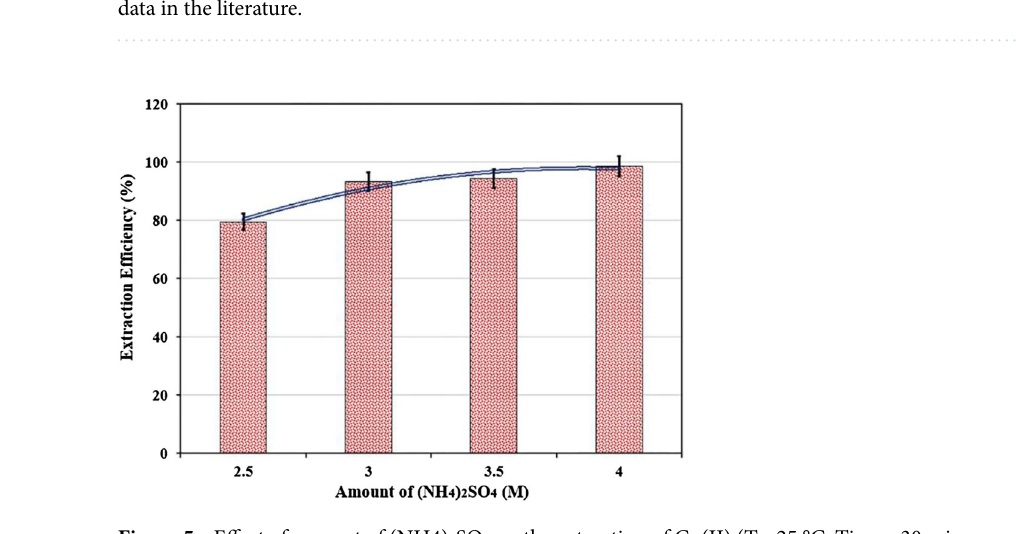
Figure 5. Effect of amount of (NH4) 2 SO 4 on the extraction of Co(II) (T = 25 °C, Time = 30 min, Co(II) = 500 ppm, PEG = 50% w/w, pH =